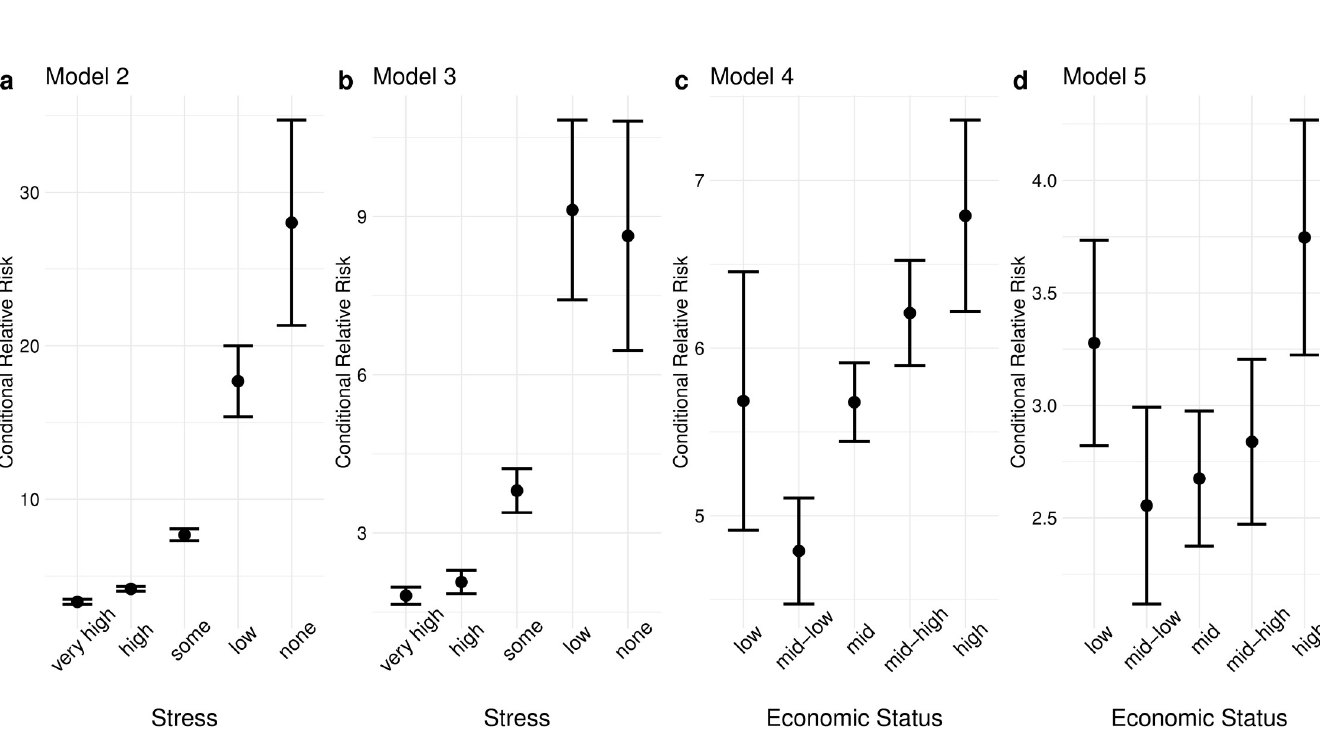
PLOS ONE | https://doi.org/10.1371/journal.pone.0250794 April 26, 2021 11 /